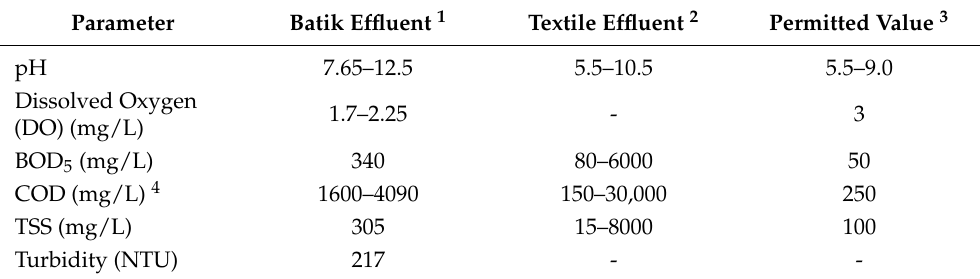
Table 3. General characteristics of untreated batik wastewater effluents compared to the common characteristics of textile wastewater, and the permitted value set by the Malaysian Department of